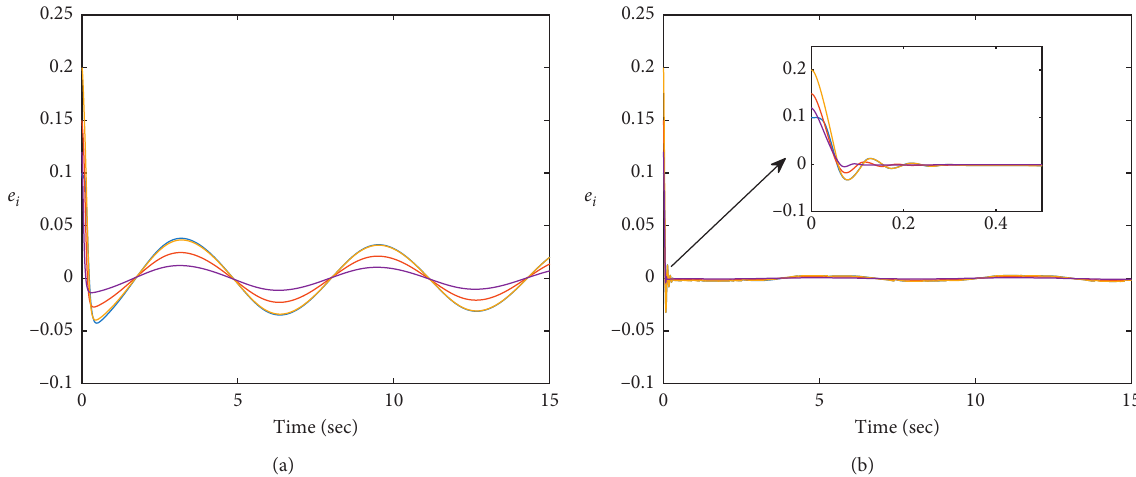
Figure 7: The tracking errors e i between followers and leader by using two methods. (a) Error curves by the method in [36]. (b) Error curves by our